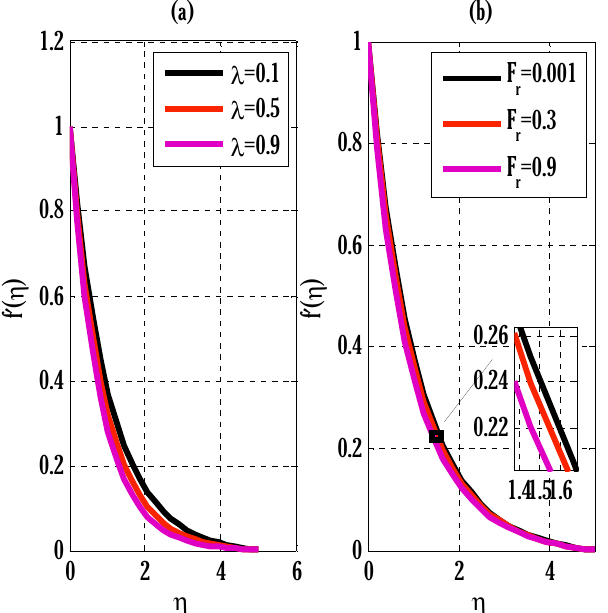
Figure 2. Varia tion of Casson parameter and electric variable on velocity profile using 𝑁 = 25,𝜆 = 0.1,𝐹 (cid:3045) = 0.1,and 𝑀 = 0.1.(𝐚) 𝐸 (cid:2869) = 0.01,(𝐛) 𝛽 = 3 .